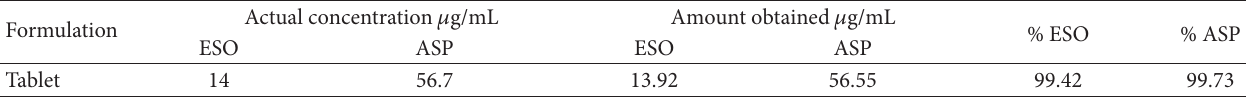
T 5: Assay results of marketed